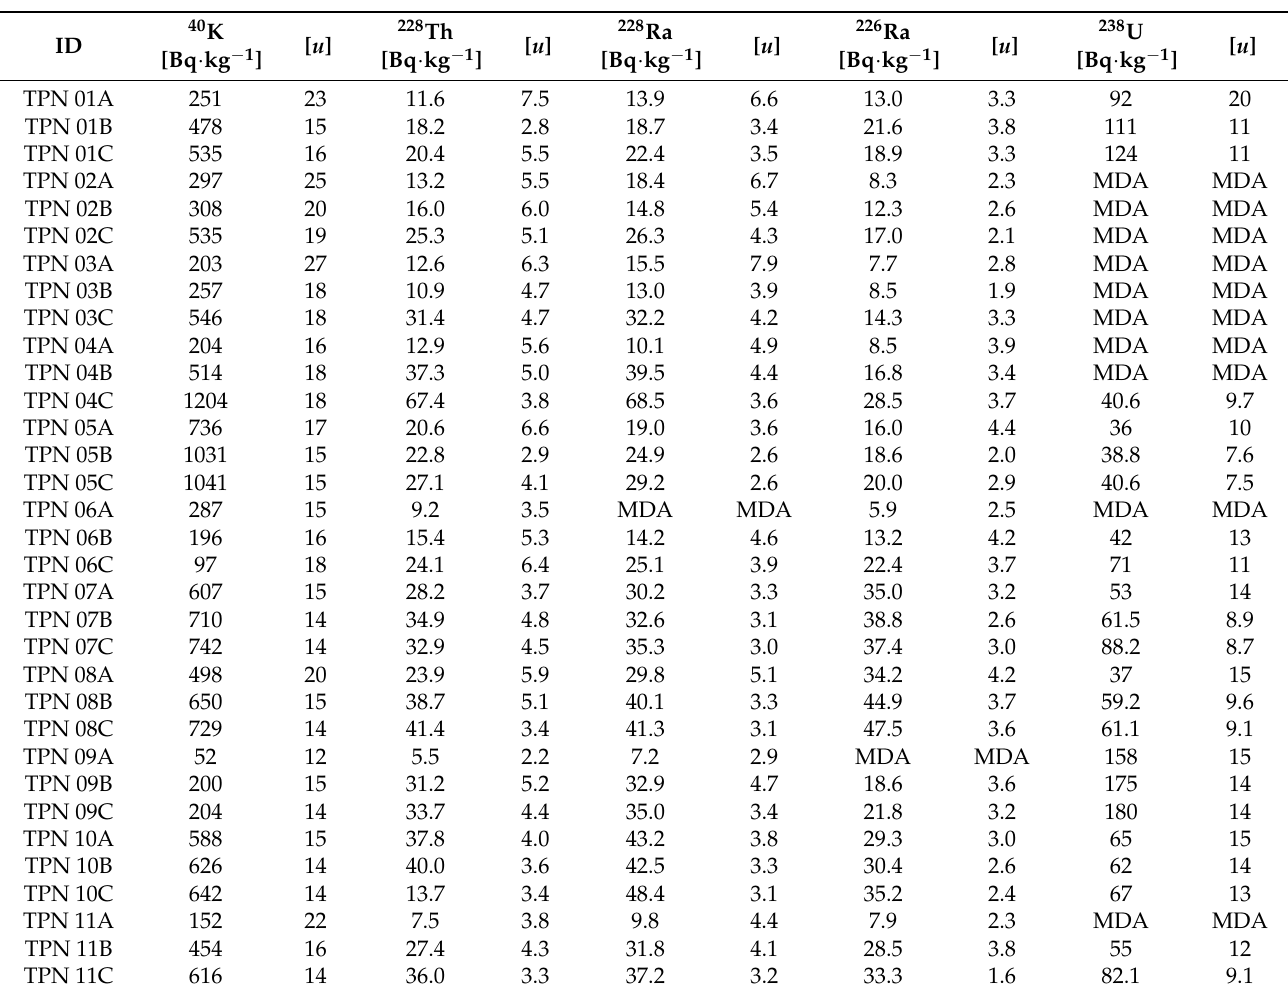
Table 3. The results of the gamma spectroscopy